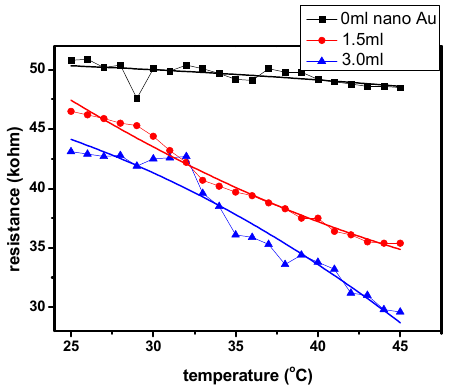
Figure 4. The variations are of resistance with temperature for two samples.